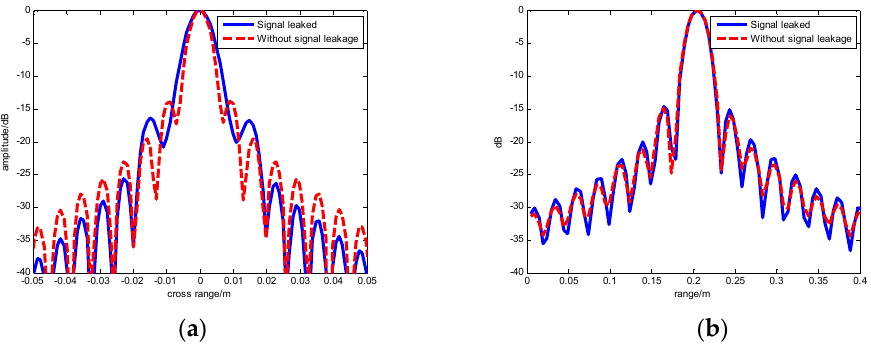
Figure 6. The comparison of PSF in two different dimensions, ( a ) is the cross range PSF and ( b ) is the range PSF.